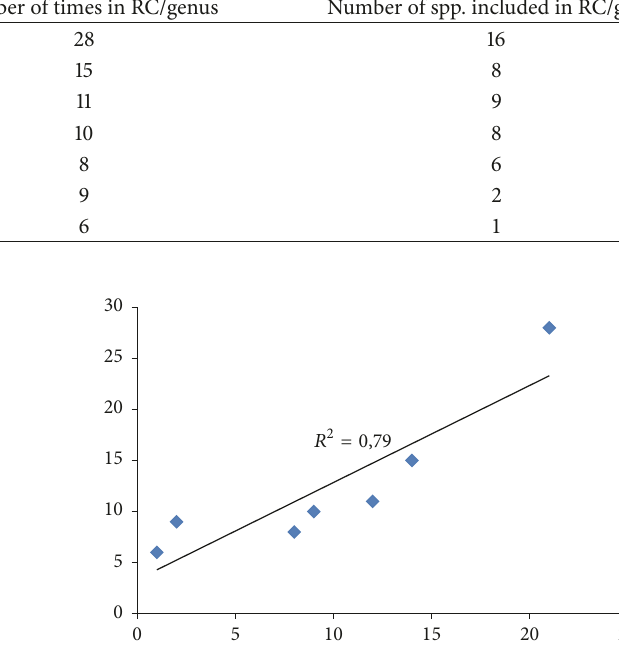
Figure 2: Relationship of regression between the number of species per genus and the number of regional catalogues (RC) in which each genus is included.